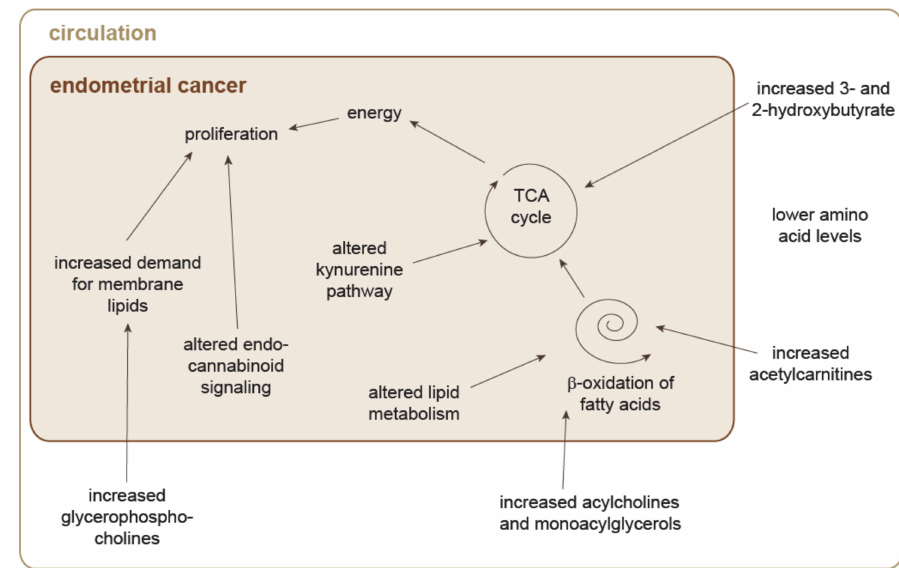
Figure 5. Speculative model of alterations in metabolic pathways in endometrial cancer based on identified biomarkers for endometrial cancer. Interactions between pathways and interactions between the cancer tissue and the circulation were not experimentally validated in the studies included into this review. Arrows do not necessarily imply causal